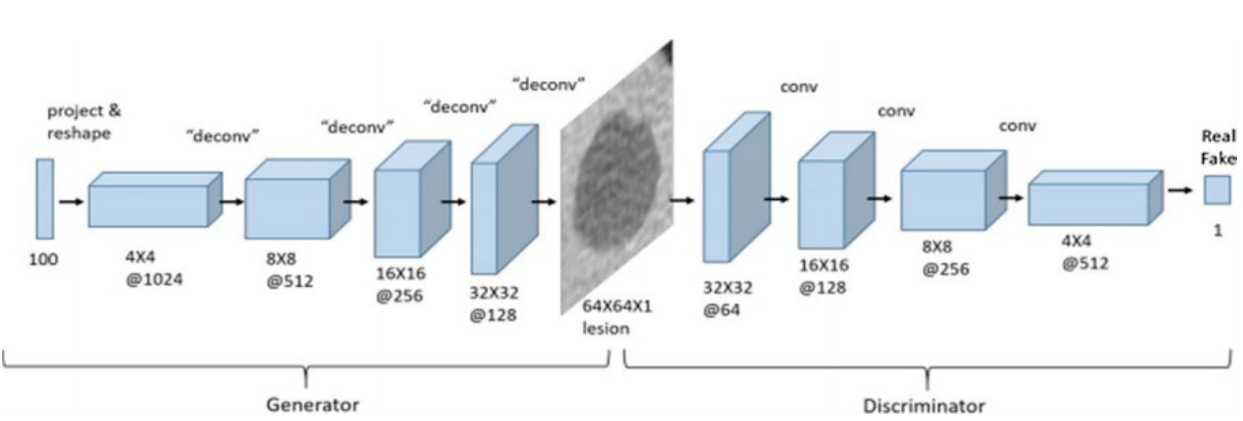
Figure 2. Generative Adversarial Network (GAN)